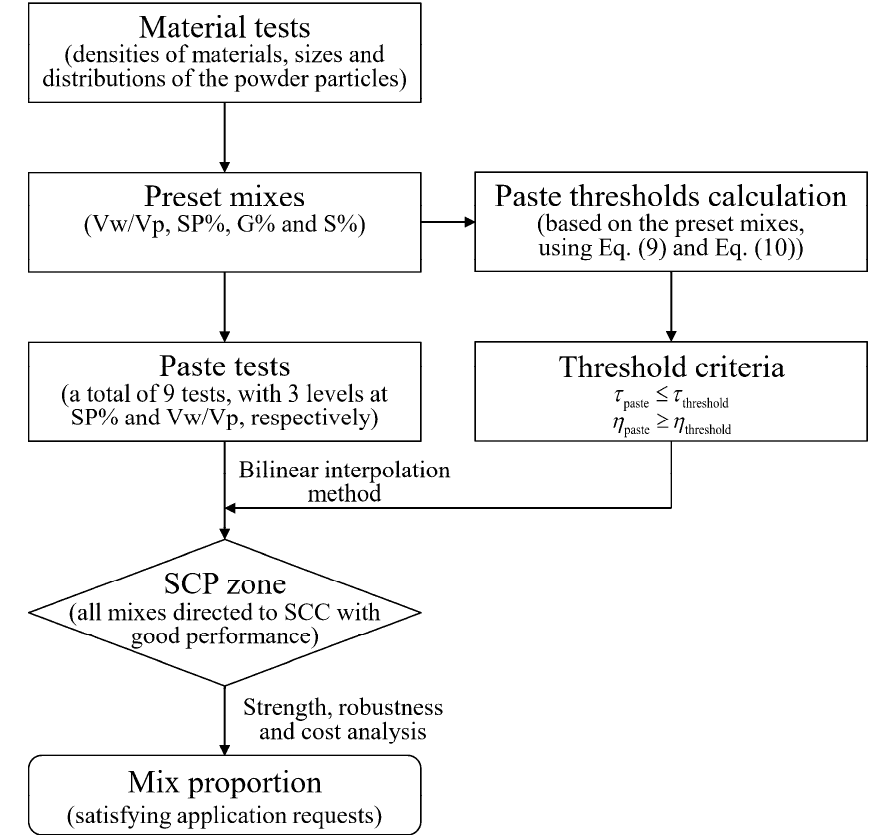
Figure 12. The mix design method for multiplexed powder